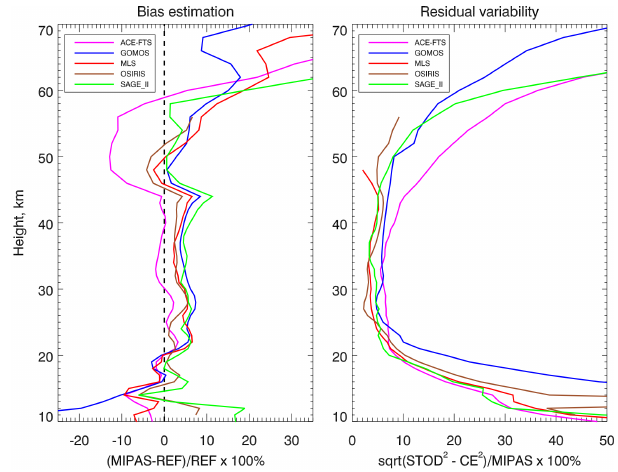
Figure 5. Bias estimation and residual variability (Eq. 6) of MIPAS ozone profiles with respect to reference instruments that are small- biased compared to ozonesondes.